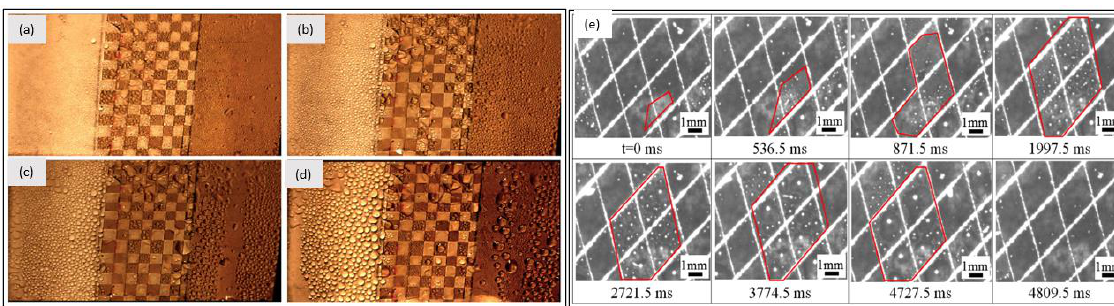
Figure 2: Composition of Stainless Steel (9).